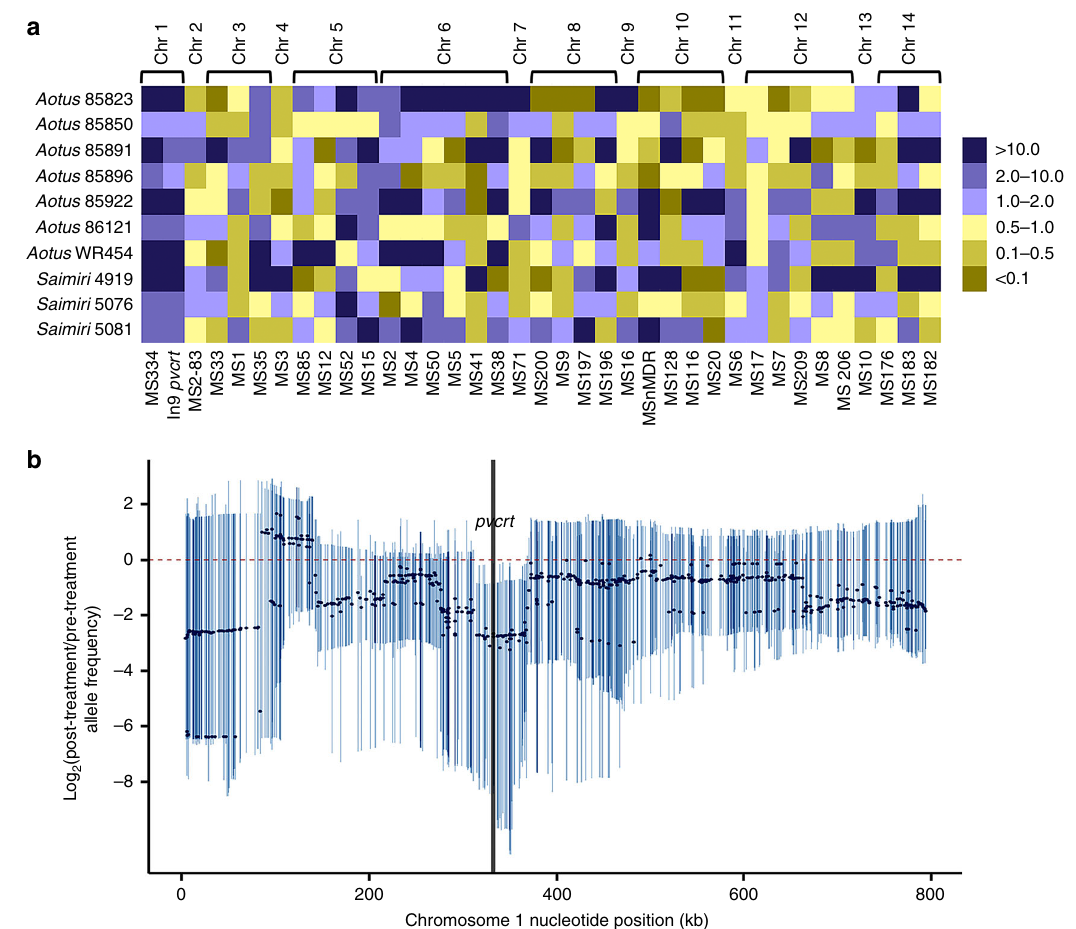
Fig. 2 Effect of CQ selection on mixed progeny populations from the NIH-1993-R× NIH-1993-S cross. a Heat map showing relative prevalences of microsatellite polymorphisms among the mixed progeny populations before and after CQ selection in Aotus or Saimiri monkeys. Colored squares in the heat map represent E values from microsatellite marker analysis of recrudescences in 10 monkeys (blue, E > 1; yellow, E < 1). Among the 14 P. vivax chromosomes, only a region of chromosome 1 shows positive selection in all samples after drug pressure (microsatellites MS334 and In9 pvcrt ). Columns with both blue and yellow squares indicate no consistent selection of any microsatellites in the other 13 chromosomes and are consistent with different combinations of individual progenies in each monkey. b Linkage group selection analysis of chromosome 1 by targeted genome sequencing. Aggregate smoothed log 2 -fold changes of pre-CQ and post-CQ treatment allele frequencies are plotted as dots; 95% CIs for individual points based on bootstrapping with replacement, are indicated by the vertical lines. A bootstrap range that does not overlap with 0 suggests selection of the corresponding region